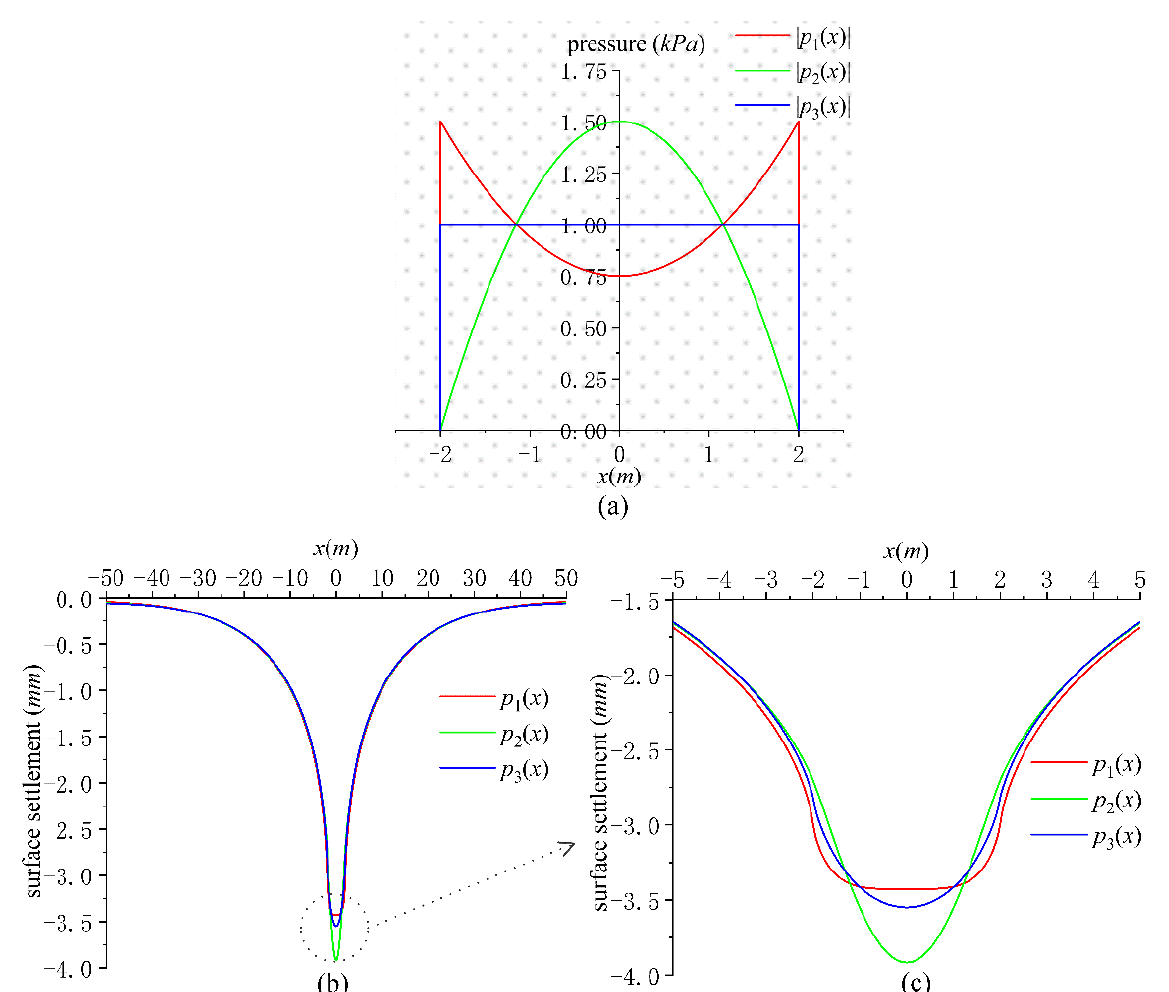
Figure 10. Three types of base pressure distribution and the surface settlement they caused: ( a ) distribution of base pressure, ( b ) surface settlement, and ( c ) surface settlement near foundation.